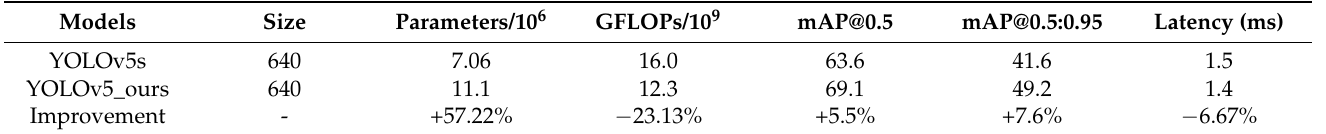
Table 7. Performance comparison between YOLOv5s and YOLOv5_ours on Pascal VOC2007 + 2012 datasets.